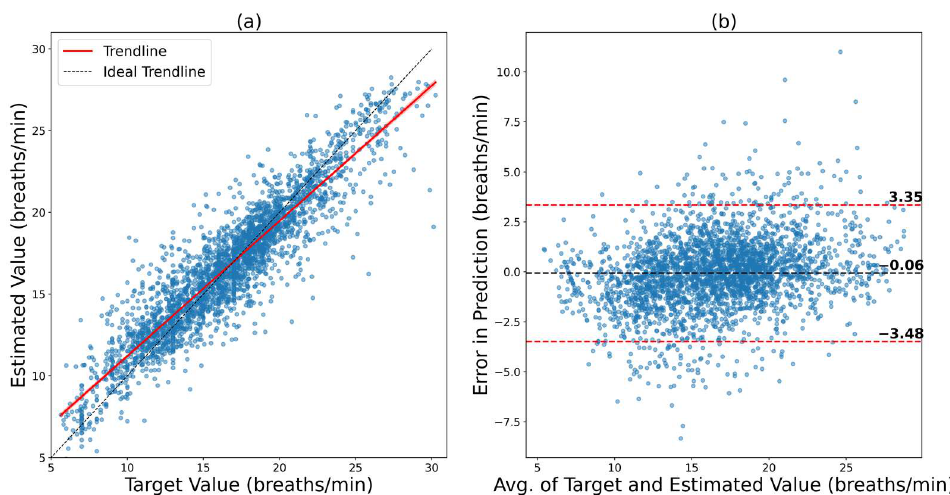
Figure 3. Results of ConvMixer on the VORTAL dataset. ( a ) Regression plot that shows how close the trendline is to the ideal trendline. ( b ) Bland–Altman plot that shows the 95% confidence interval of the error.